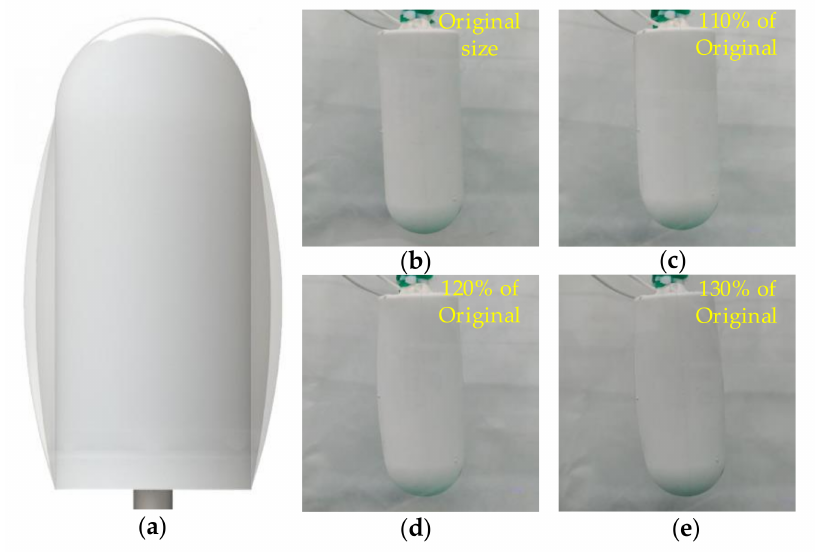
Figure 3. The form of buoyancy control module (BCM) in operation: ( a ) shape change; ( b ) original state; ( c ) 110% of original size; ( d ) 120% of original size; ( e ) 130% of original